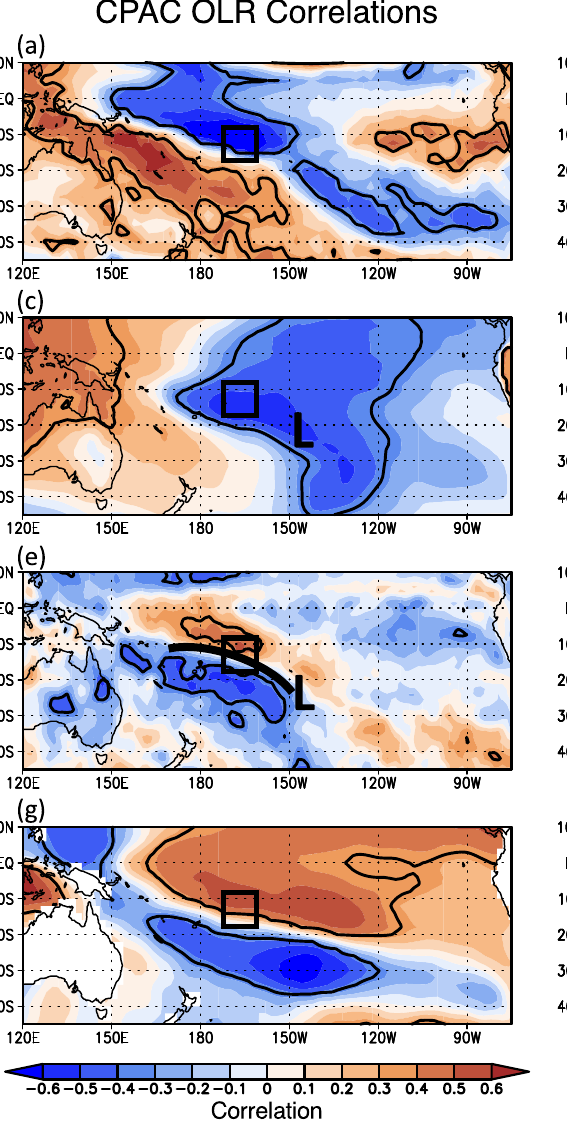
Fig. 5 The local synoptic conditions governing CPAC convection. The detrended DJFM (left) CPAC OLR correlations and (right) standardized CPAC OLR regressions with a , b OLR, c , d MSLP, e , f 925 hPa temperature advection, and g , h SST during 1991 – 2015. Also shown on the right are regressions with 10 m wind for ( b , d , h ) and 925 hPa wind for ( f ). The correlations/regressions are multiplied by − 1 to show conditions associated with enhanced CPAC convection. The bold contours denote correlations and regressions signi fi cant at p < 0.10, and wind vectors are shown only if at least one regression component is signi fi cant at p < 0.10. The CPAC area (10 – 15°S, 170 – 165°W) is denoted by the black box, and the position of the surface low-pressure center and its cold front are denoted by an “ L ” and curved black line, level pressure anomalies between Tahiti (eastern tropical Paci fi c) and Darwin, reanalysis ERA5 50 . ERA5 replaces the ECMWF Interim (ERA-Interim) reanalysis, Australia (west Paci fi c warm pool), obtained from the NOAA Climate Prediction which was considered to be the best reanalysis for depicting Southern Hemisphere Center (https://www.cpc.ncep.noaa.gov/data/indices/). The Southern Annular high-latitude climate 51 , with improved model physics, core dynamics, and data Mode (SAM) is investigated using the observation-based index of 25 , which is the assimilation as well as a higher horizontal resolution. We use monthly-mean ERA5 fi elds to compute the seasonal means employed in the correlation analysis, and difference in standardized zonal-mean sea level pressure between 40°S and 65°S. 6-hourly fi elds to compute the 5-day group means investigated for the two case Variability in central tropical Paci fi c (CPAC) deep convection is investigated using studies. Anomalies for the two pentads in Fig. 3a, b, d, e are from the 1981 – 2010 the OLR area-averaged over the region 10 – 15°S, 170 – 165°W. Circulation variability climatological mean. over Drake Passage (Drake Z500) is investigated using the area-averaged ERA5 500 Tropical variability is investigated using monthly-mean sea surface temperature hPa geopotential height over the region 57 – 62°S, 81 – 71°W. All area averages are (SST) data from the National Oceanic and Atmospheric Administration (NOAA) weighted by the cosine of the latitude. Extended Reconstructed SST Version 5 (ERSSTv5) dataset 52 , which has a horizontal grid spacing of 2°×2°. We investigate variability in tropical deep convection using the monthly and daily-mean fi elds of outgoing longwave radiation (OLR) from the Larsen C ice shelf surface melt . Surface melt on the Larsen C Ice Shelf was NOAA Interpolated OLR dataset 53 , which has a 2.5°×2.5° horizontal grid spacing. derived from a modeling experiment using the Polar Weather Research and Both the ERSSTv5 and OLR datasets were obtained online from the NOAA Physical Forecasting Model (Polar-WRF version 3.9.1) over the period December 1991 to Sciences Laboratory (https://psl.noaa.gov/data/gridded/). March 2015. Polar-WRF is a state ‐ of ‐ the ‐ art limited ‐ area mesoscale modeling Variability in the El Niño-Southern Oscillation is investigated using the system 54 , which is a polar-optimized version of the WRF model 55 . The model Southern Oscillation Index (SOI), which is the difference in standardized mean sea includes modi fi ed land-surface model sea ice representation as well as enhanced